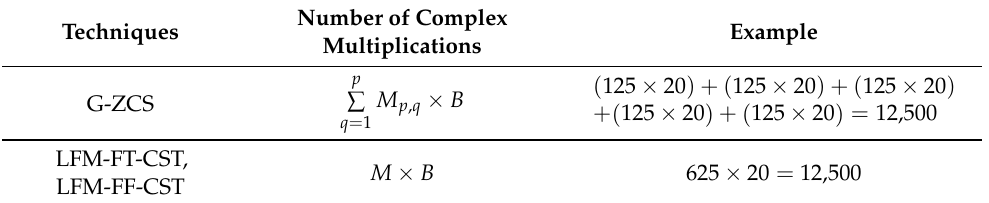
Table 4. Computational